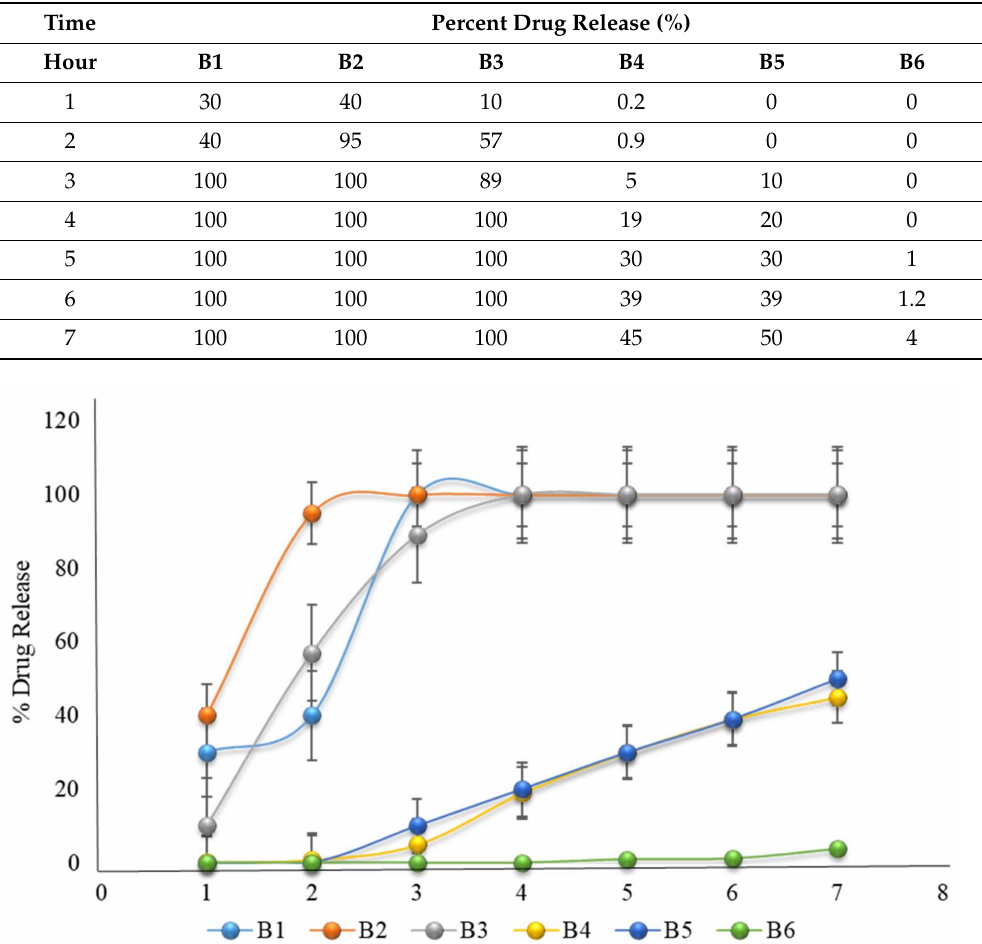
Table 6. The in vitro dissolution of formulations B1 to B6 (the first 2 h in an acidic medium of pH 1.2, then in a phosphate buffer medium of pH 6.8).